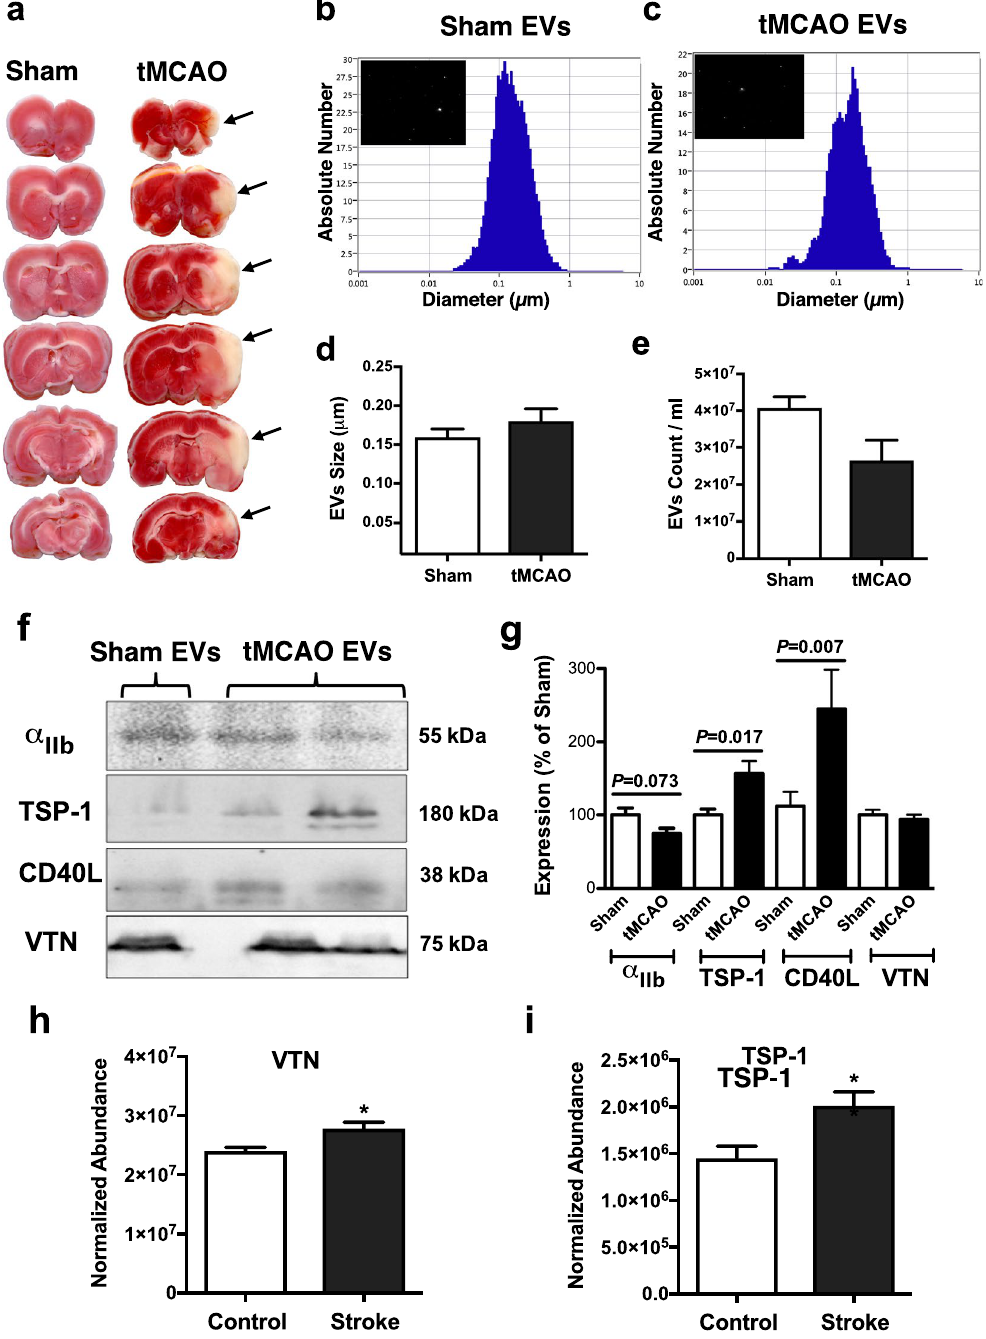
Figure 4. RGD protein expression in extracellular vesicles (EVs) in ischemic stroke . ( a ) Triphenyltetrazolium chloride-stained brain slices of rats after tMCAO show ischemic brain areas (outlined – right panel). EVs were isolated and measured using light scattering technology in the serum of sham ( b ) and tMCAO ( c ) animals. Quantification was performed for both size ( d ) and number of EVs/ml ( e ). Representative Western immunoblots ( f ) and summary of densitometry data ( g ) show changes in expression of integrin α IIb, thrombospondin-1 (TSP-1), CD40 ligand (CD40L) and vitronectin (VTN) in EVs isolated from sham-operated or tMCAO rats. Average-fold change in peptide sequences identified as vitronectin ( h ) and thrombospondin-1 ( i ) in EVs harvested from patients with ischemic stroke and age-matched controls, as measured using LC-MS/ MS. Data are mean ± SEM; * p <